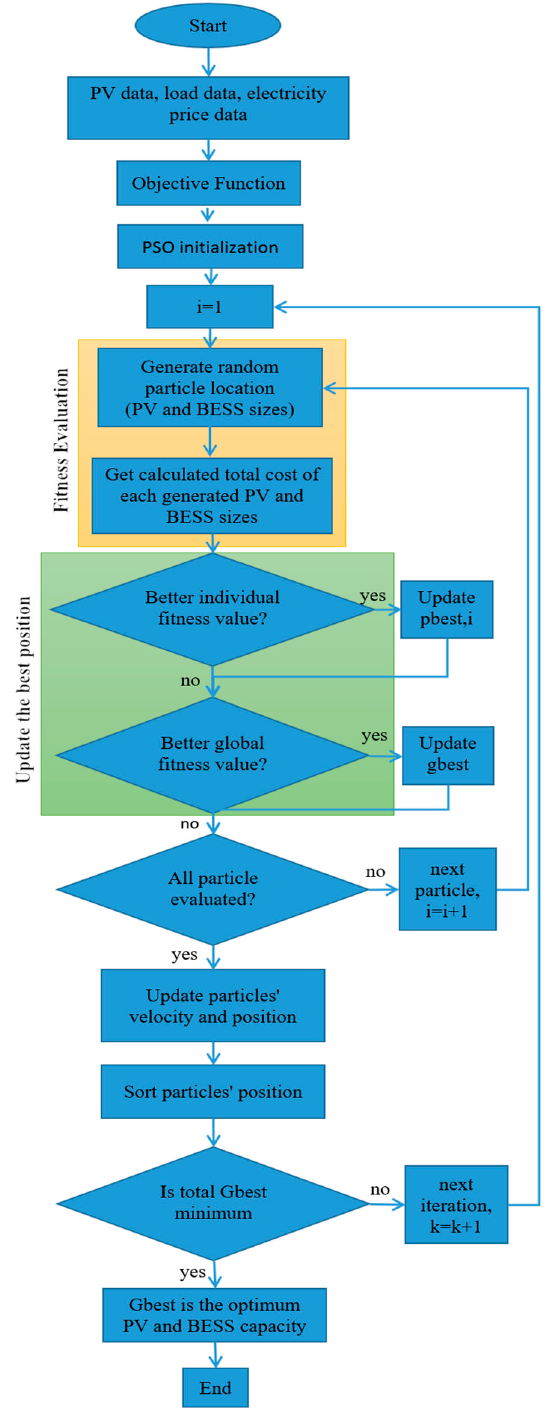
Figure 5. Proposed PSO algorithm flowchart.